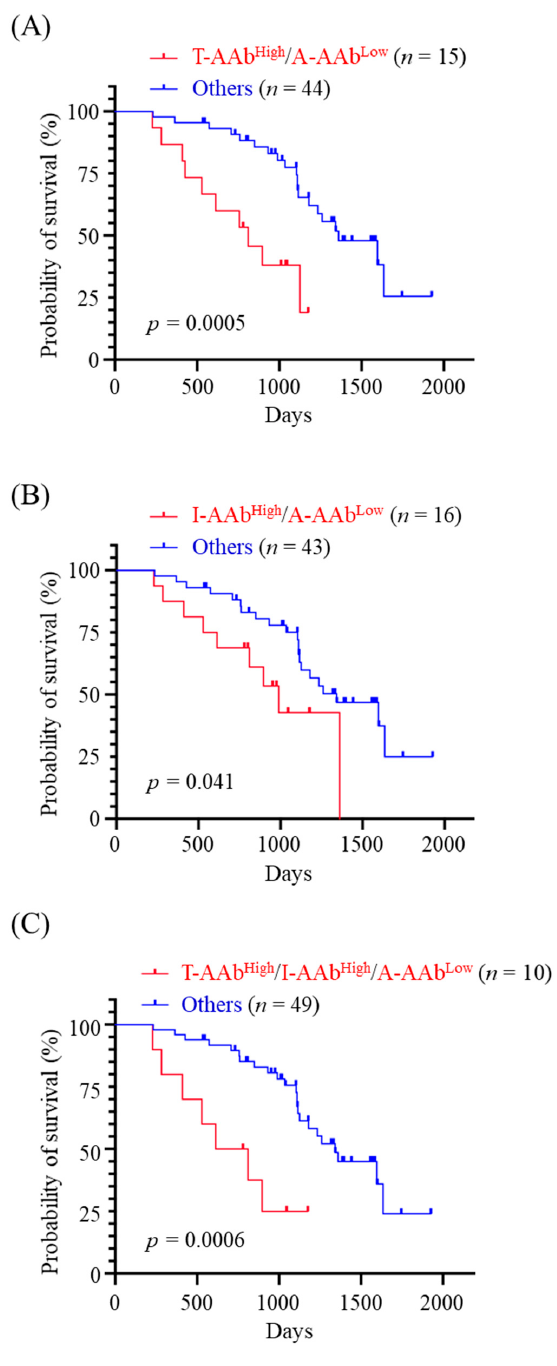
Figure 6. Correlation between the combined panels of serum AAb levels and OS of dogs with non- metastasized MMT. Dogs with non-metastatic MMT ( n = 59 in stage I, II, or III) were dichotomized by a combination of ( A ) TYMS-AAb High and AGR2-AAb Low (denoted T-AAb High /A-AAb Low ), ( B ) IGFBP5-AAb High and AGR2-AAb Low (denoted I-AAb High /A-AAb Low ), and ( C ) TYMS-AAb High , IGFBP5-AAb High , and AGR2-AAb Low (denoted T-AAb High /I-AAb High /A-AAb Low ), respectively. OST of non-metastasized MMT dogs was compared between the dichotomous groups by using Kaplan-Meier analysis. Statistical significance was determined by the log-ranked test.